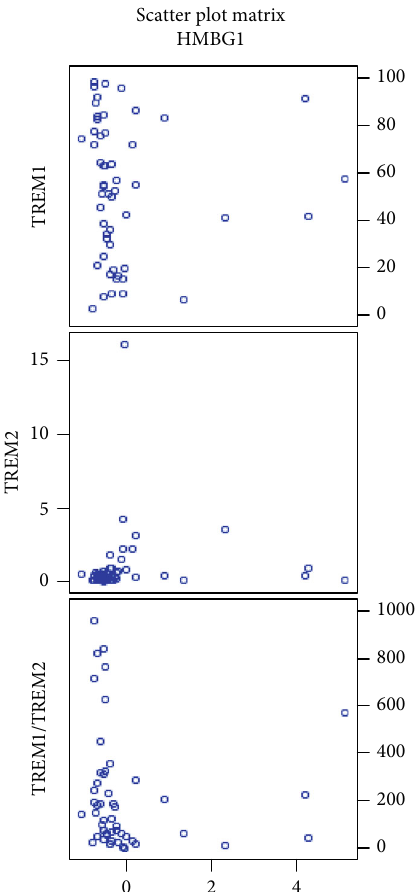
Figure 7: Scatter plots showing correlations of HMGB1 with percentage of CD14 + TREM-1 + cells, CD14 + TREM-2 + cells, and TREM-1/TREM-2 ratio in all gliomas (HMGB1 values corrected by a Z -score).